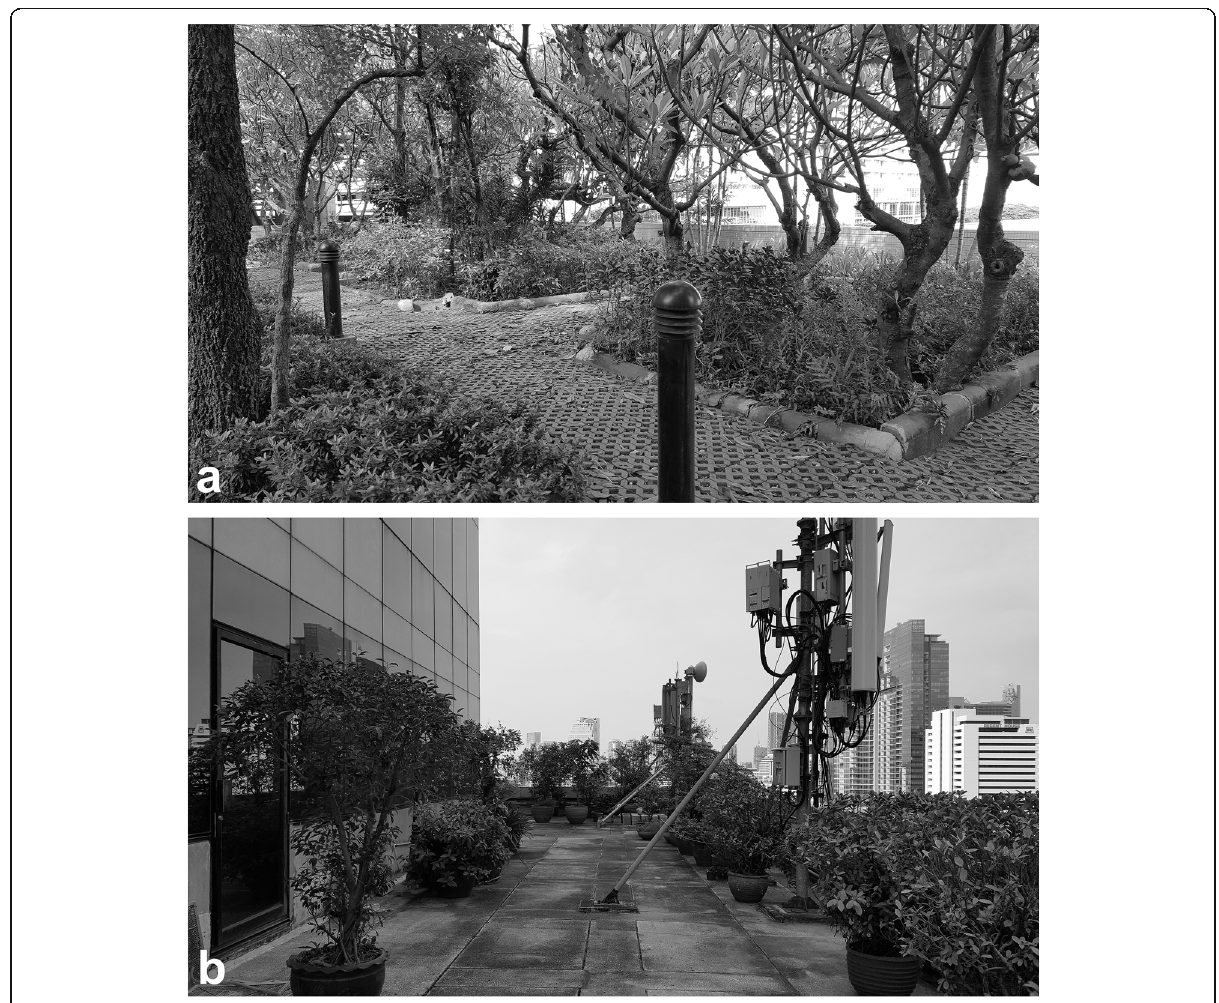
Fig. 2 Examples of the green roofs in this study: a MHT and b